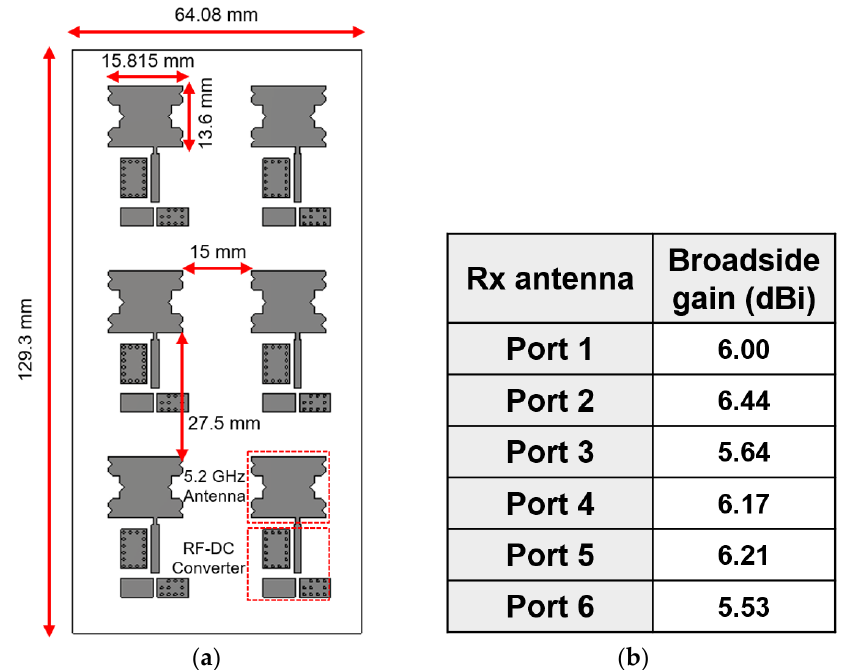
Figure 8. ( a ) 2 × 3 Rx module antenna arrangement and ( b ) Specifications. Reprint with